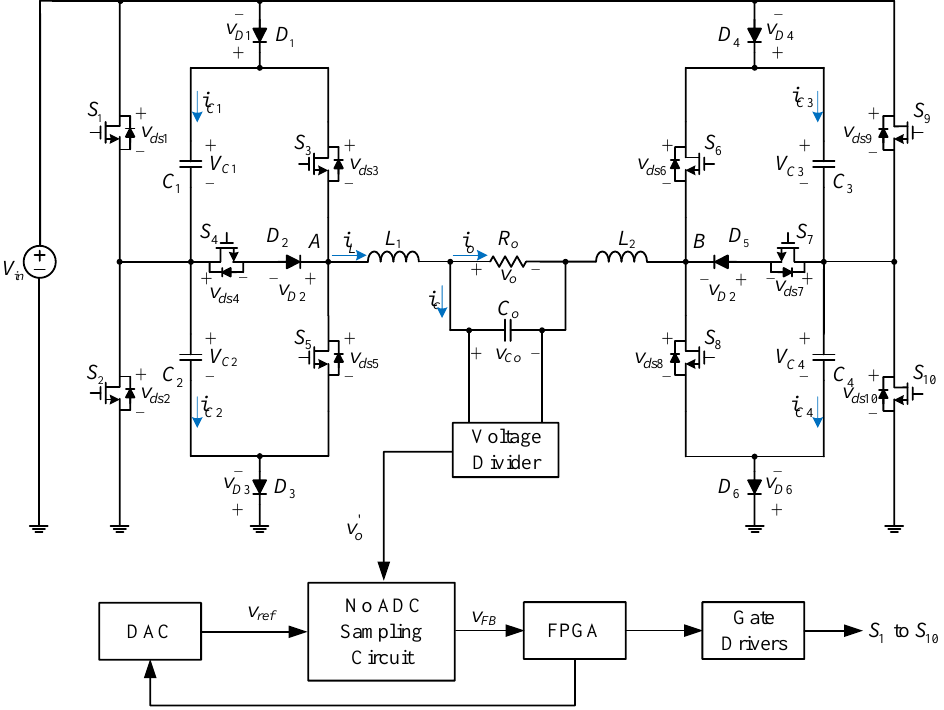
Figure 14. System configuration for the 7-level single-phase DC-AC inverter.